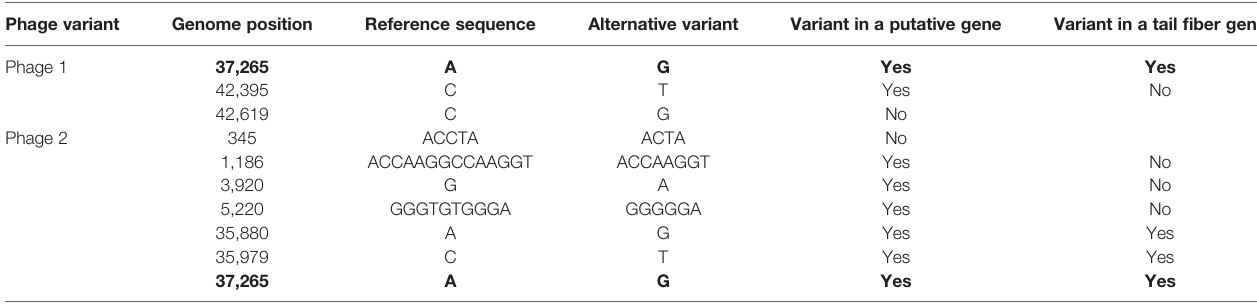
TABLE 1 | Genetic differences between Phage 1 (P1) and Phage 2